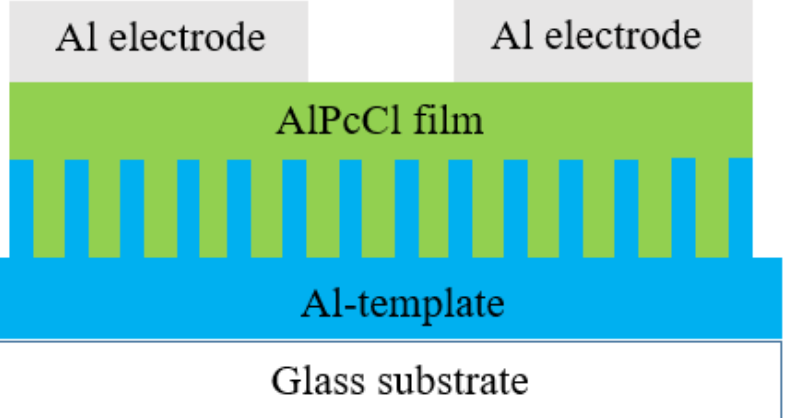
Figure 5. Schematic process flow of AlPcCl-AAO composite humidity sensor with solution meth- od.